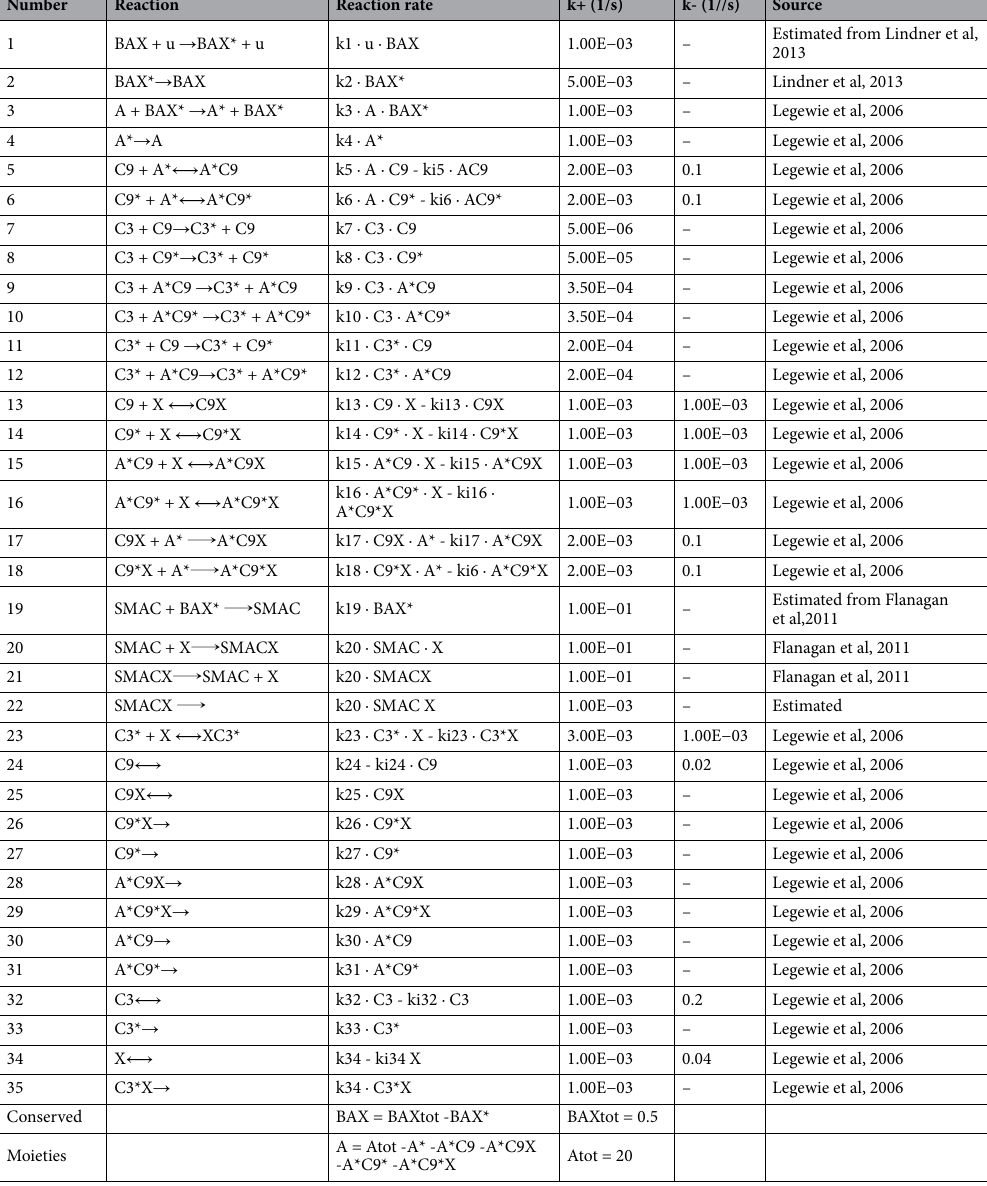
Table 1. Table of model reactions and reaction